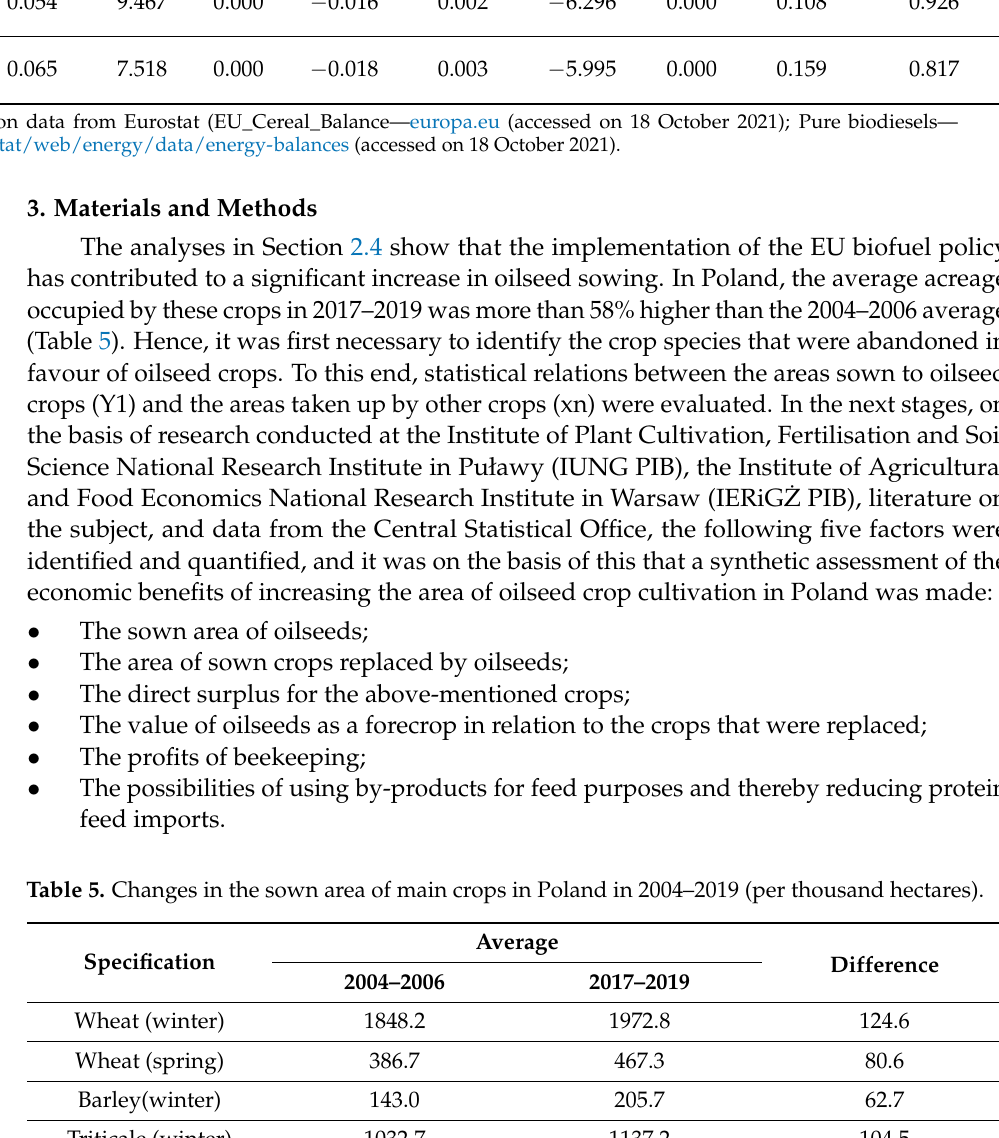
Table 4. Quadratic trend models for total oilseed crops and oilseed rape and colza area and their statistical characteristics. b 1 Parameter Characteristic b 2 Parameter Characteristic Specification R-SquaredEstimate Stan. Error Total 0.507 0.054 9.467 0.000 oilseeds Rape and turnip rape